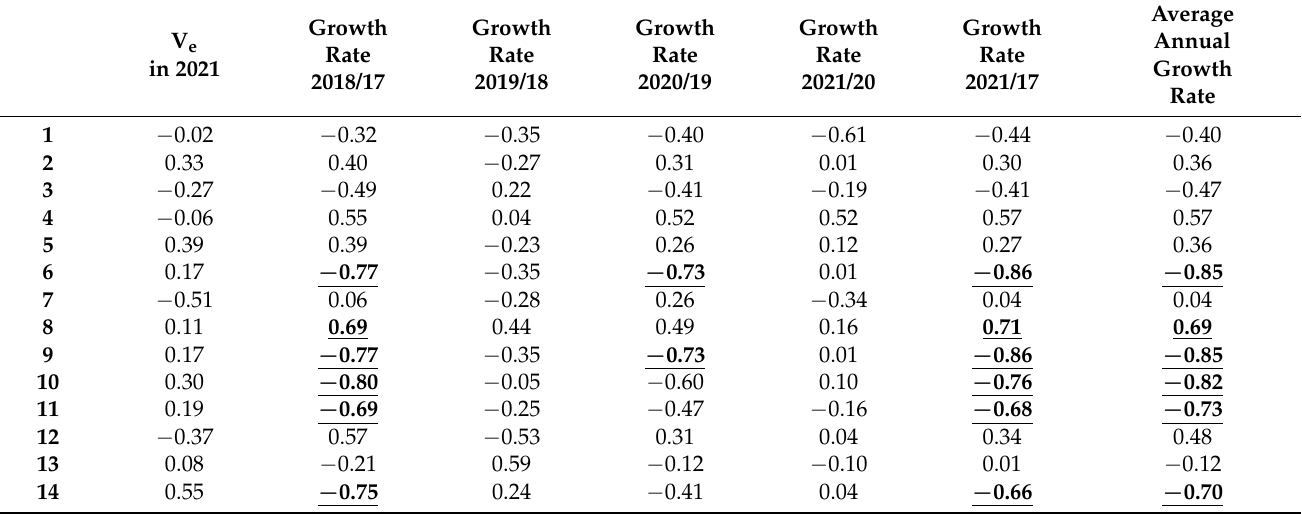
Table 5. Correlation coefficients between root anatomical characteristics and ‘Summit’ cherry crown parameters (underlined bold values were statistically significant at p < 0.05 according to Persons’